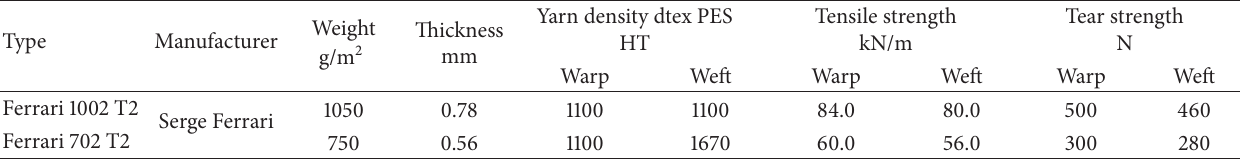
Table 1: Specifications of test